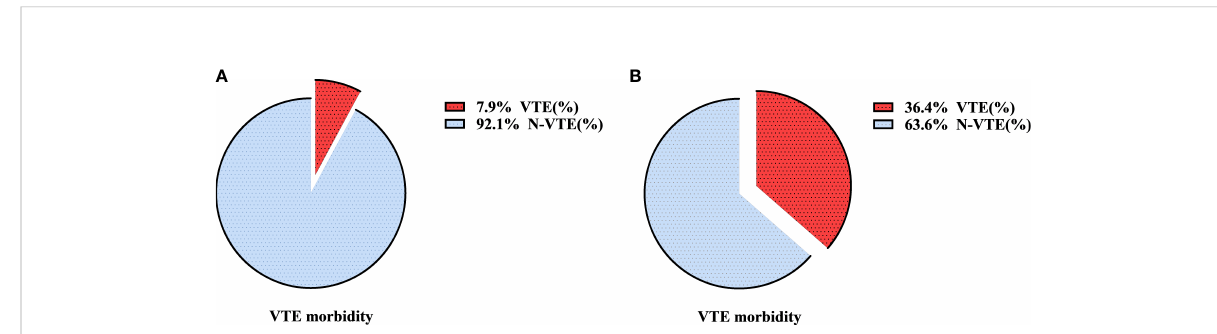
FIGURE 3 The incidence of VTE in intermediate-high risk with AIS after modi fi ed Caprini RAM when remaining the “ malignant tumor ” item (A) or removing the “ malignant tumor ” item (B) . VTE, venous thromboembolism; RAM, risk assessment model; AIS, adenocarcinoma in situ